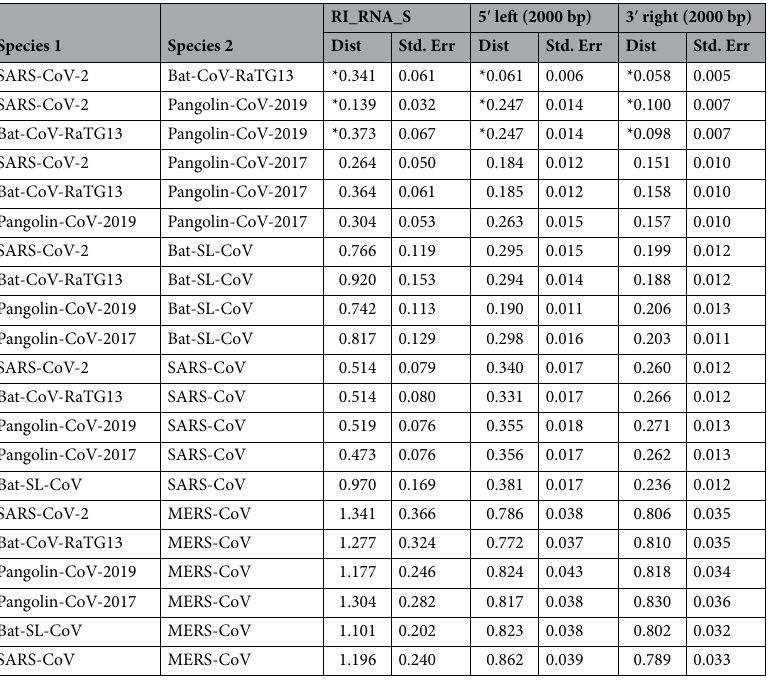
Table 2. Estimates of evolutionary divergence between coronavirus sequences obtained using the Tajima-Nei model. Analyses were performed on the sequences of RI_RNA_S (from 22,870 to 23,099 bp corresponding to MN908947), the 5 ′ left 2000 bp region (from 20,870 to 22,869 bp) and the 3 ′ right 2000 bp region (from 23,099 to 25,099 bp). The coronavirus genomes being compared are SARS-CoV-2 (MN908947), Bat-CoV-RaTG13 (MN996532), Pangolin-CoV-2019 (410,721), Pangolin-CoV-2017 (410,542), Bat-SL-CoV (MG772933), SARS-CoV (NC_004718) and MERS-CoV (NC_019843). ‘Dist.’ denotes genetic distance. ‘Std. Err’ denotes the standard error estimate(s). For convenience, we underlined the presumed recombinant (SARS-CoV-2). The values between the presumed recombinant and parents are marked by